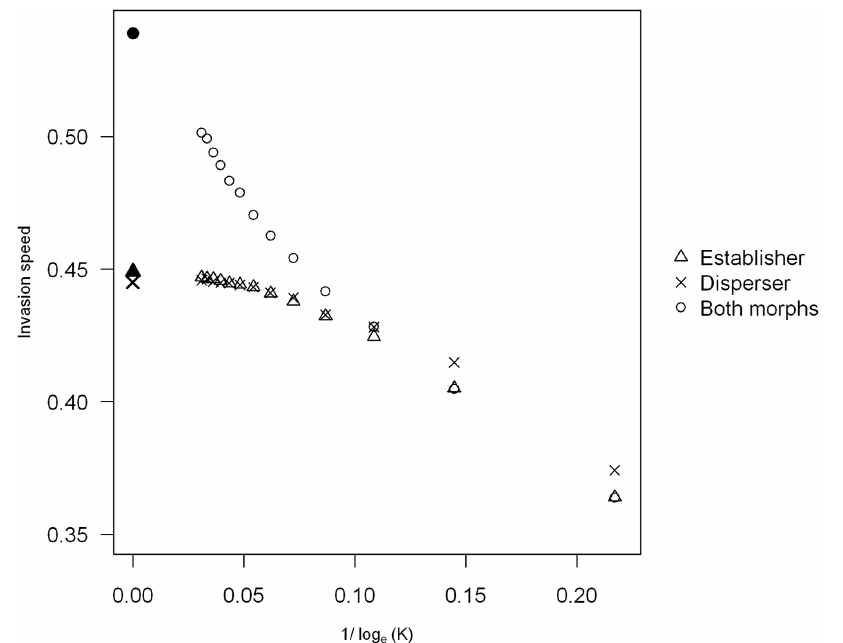
Figure 4. Comparison of invasion speeds with different values of m . The parameter values are the same as in Fig 3(c) with the value of m varied from m ~ 0 : 001 (crosses), m ~ 0 : 005 (diamonds), m ~ 0 : 01 (circles), m ~ 0 : 05 (plus) and m ~ 0 : 1 (triangles point down). The filled circle represents the polymorphic deterministic speed which is the same for all mutation rates. The triangles point up represent the fastest single morphs speed, which here is the establisher, with the filled triangle the deterministic speed.